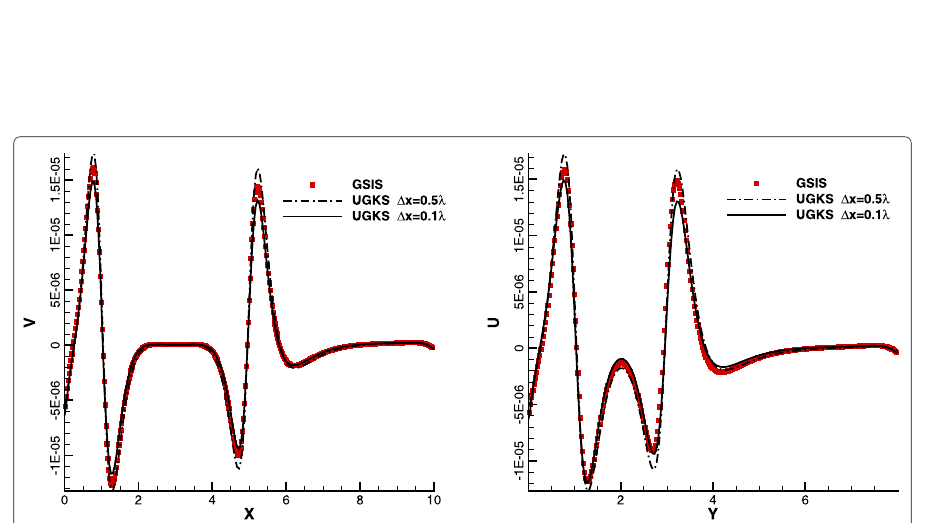
Fig. 17 Left figure shows the y-direction velocity profile along y = 0.5, and right figure shows the x-direction velocity profile along x = 0.5. The UGKS result with (cid:4) x = 0.5 λ is shown in dash-dotted line; the UGKS result with (cid:4) x = 0.1 λ is shown in solid line; and the GSIS solution is shown in